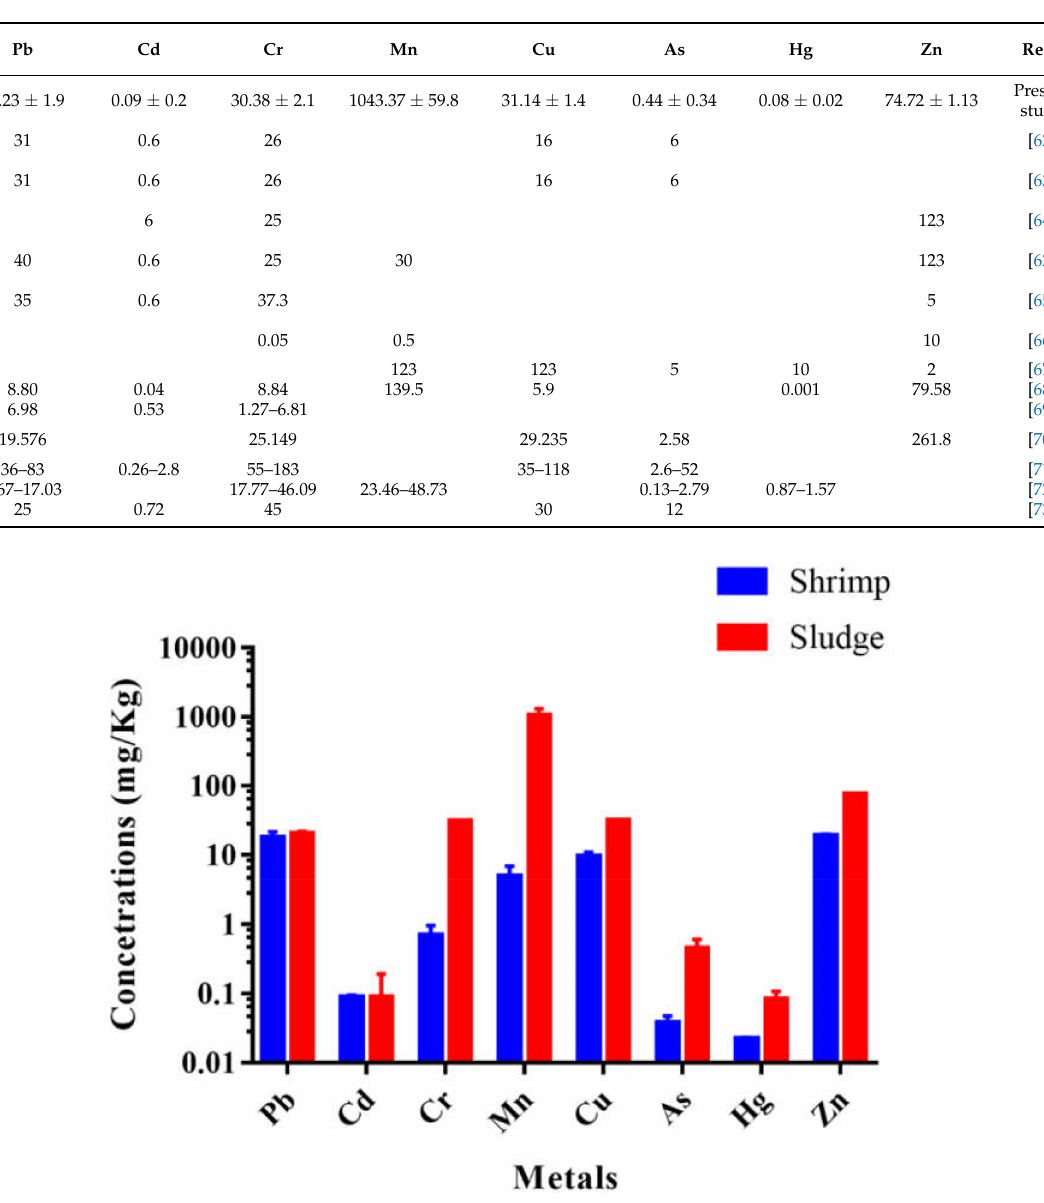
Table 2. Comparison of heavy metals (Mean ± SD) in shrimp aquaculture sludge samples with various standard levels and relevant study (mg/kg wet weight).